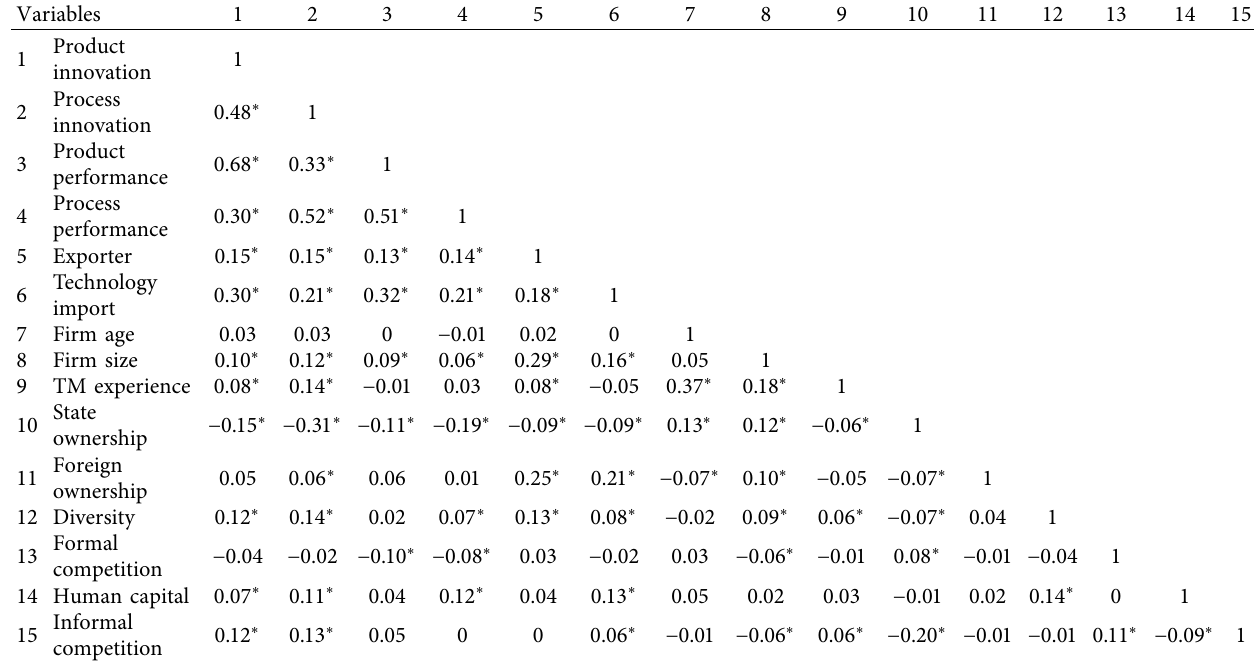
Table 3: Coefficients matrix N � 1193.